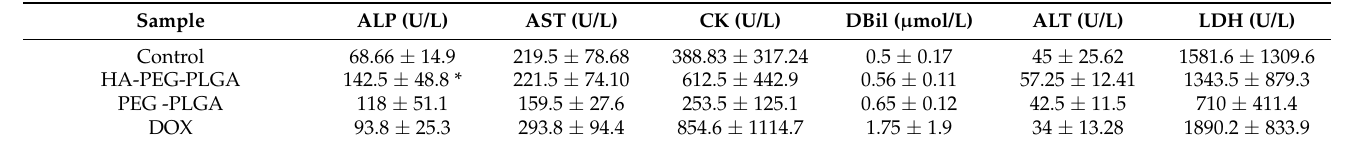
Table 1. Serum biochemistry results obtained at the end of experiment for all treated mice.